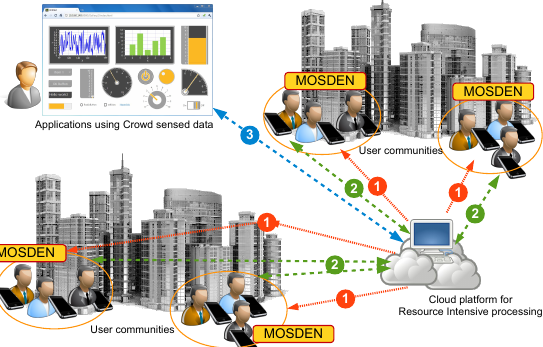
Figure 1. Environmental Monitoring - Mobile Opportunistic Sensing